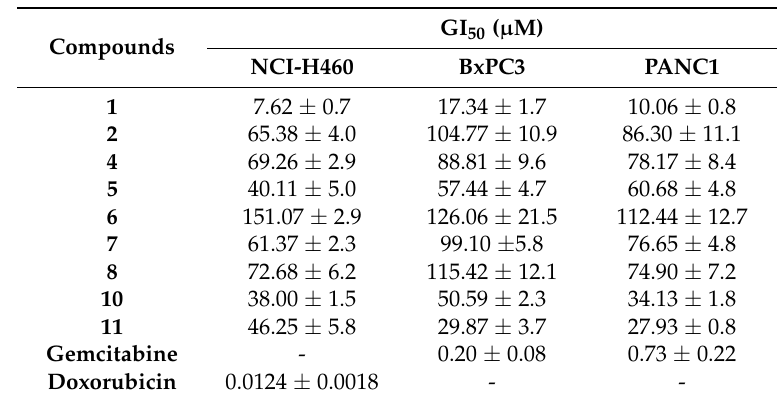
Table 1. Growth inhibition (GI 50 ) concentration of 1 – 2 , 4 – 8 , 10 , and 11 against NCI-H460, BxPC3, and PANC1 human tumor cell